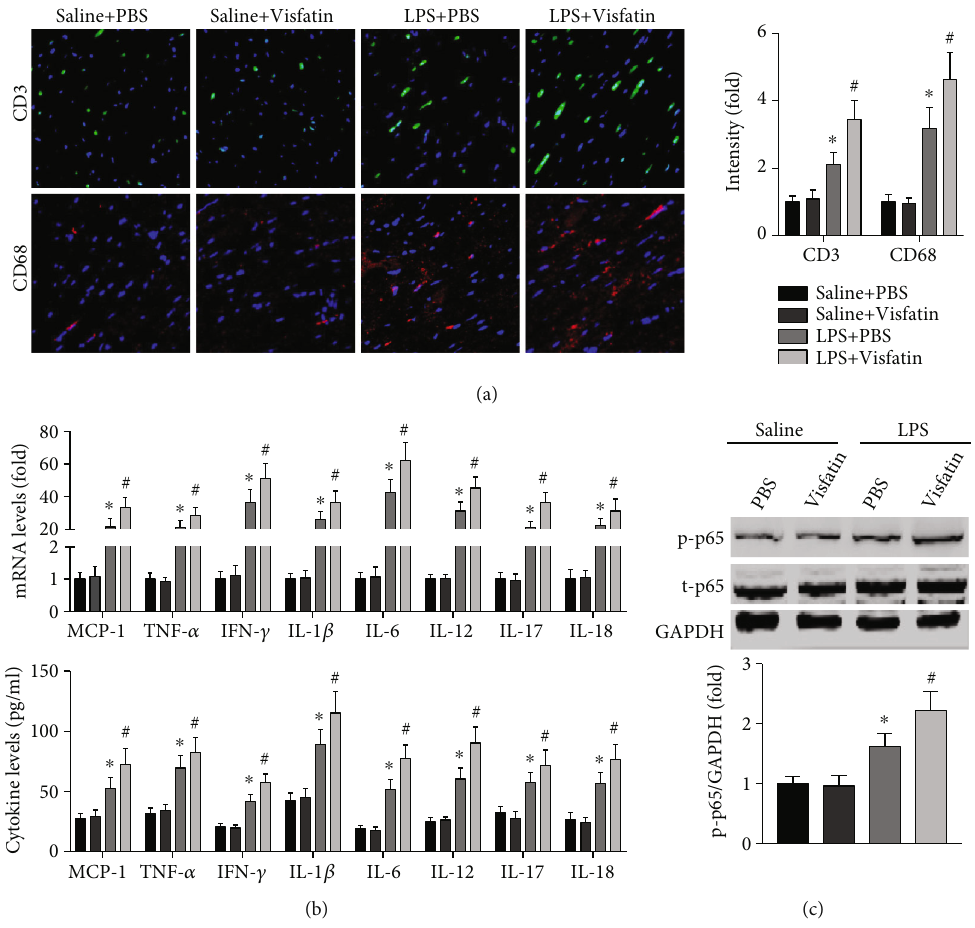
Figure 3: E ff ects of visfatin on cardiac in fl ammation in LPS-treated mice. (a) Cardiac CD3+ cells and CD68+ cells in the four groups were examined. (b) The expression of MCP-1, TNF- α , IFN- γ , IL-1 β , IL-6, IL-12, IL-17, and IL-18 in the heart and serum was detected. (c) The activation of the NF- κ B p65 pathway was measured. N = 5 − 6 in each group. ∗ p < 0 : 05 vs. the saline+ PBS group. # p < 0 : 05 vs. the LPS+PBS